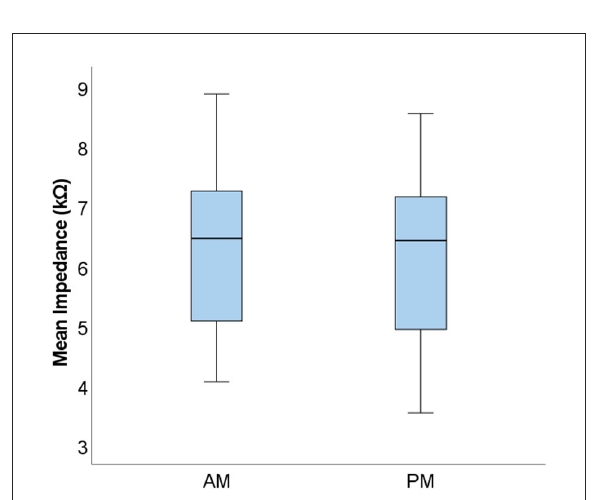
FIGURE4 Boxplots displaying group level mean AM and PM impedances. Mean values calculated from the four electrode groupings are shown ( N =